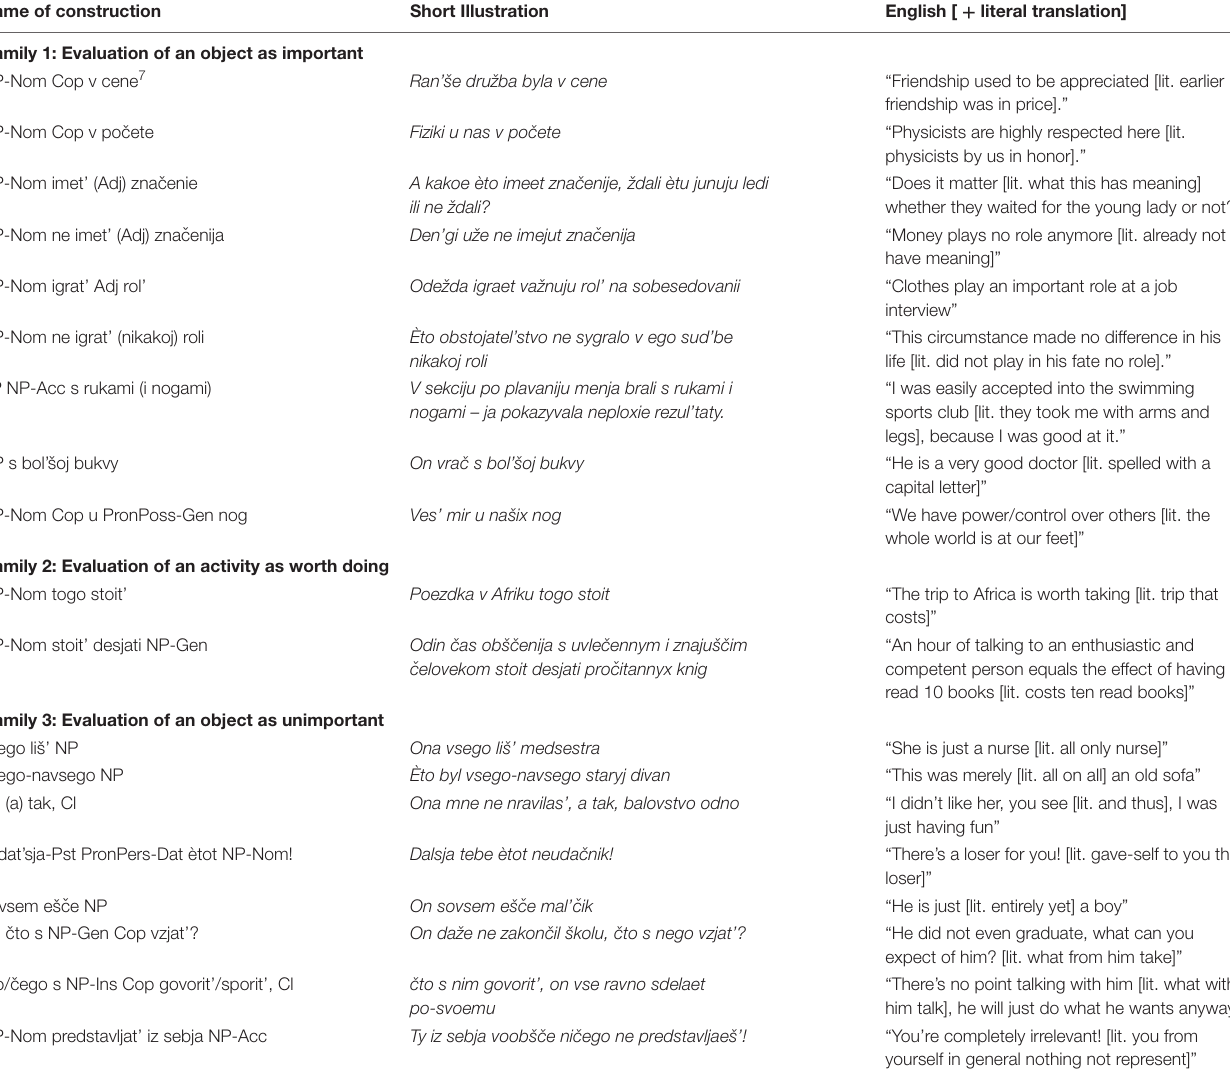
TABLE 1 | Three families of Assessment constructions. Name of construction Short Illustration English [ + literal